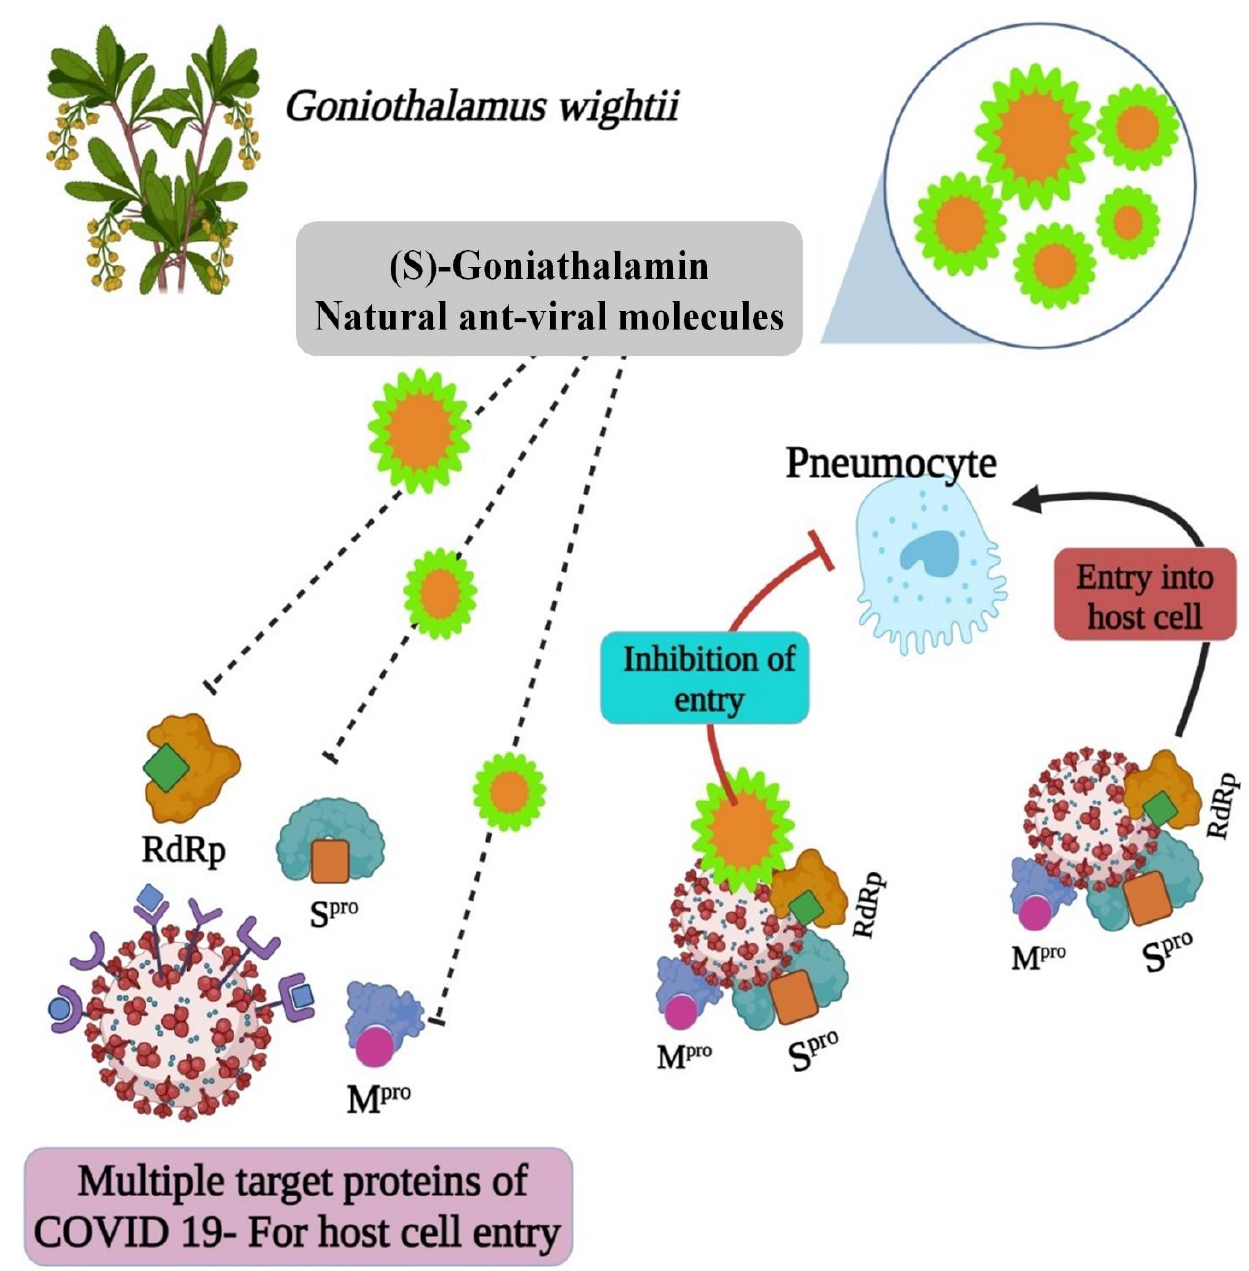
Figure 12. The mechanism of bioactive compound against SARS-CoV-2.